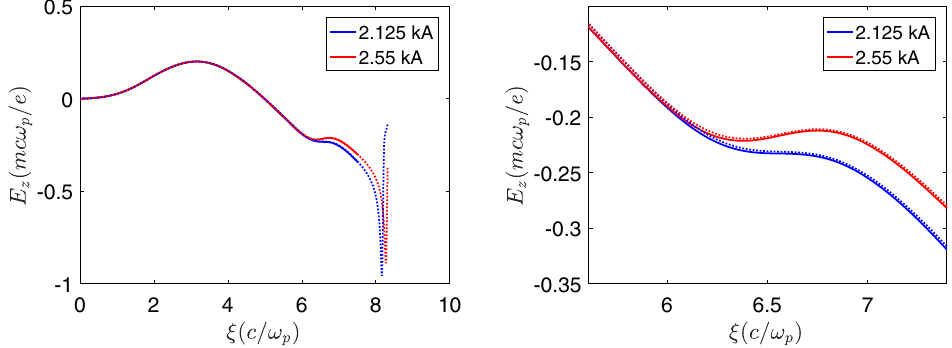
FIG. 2. On-axis longitudinal electric field E z ð 0 ; ξ Þ as a function of ξ (scaled units). We show the results from our code (solid lines) versus Q UICK PIC data (dotted lines) for two different values of the witness beam current. The right figure focuses on the immediate neighborhood of the witness beam, while the left figure shows the full range of ξ . For the left figure, we intentionally use a shorter ξ -range for our results in order to visualize the Q UICK PIC data more